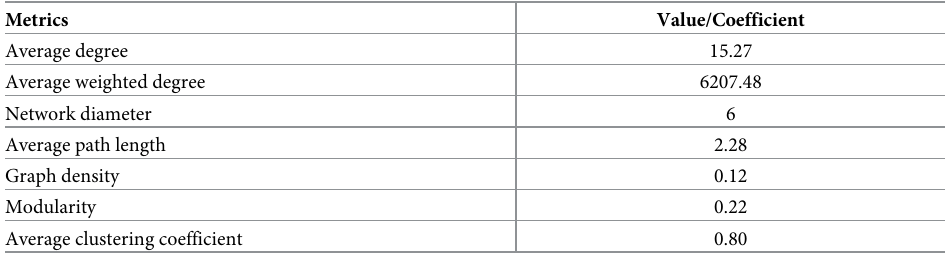
Table 9. The metrics related to the network of specializations based on common competencies.